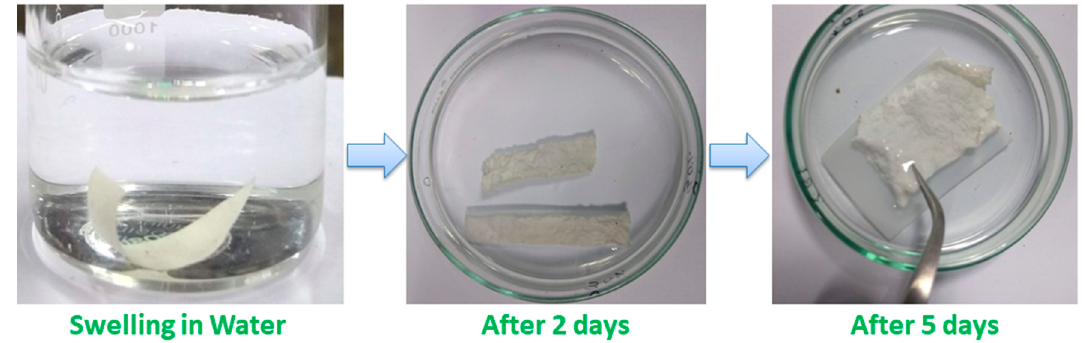
Figure 6. Swelling of composite films with 25% CNFs in deionized water with time.